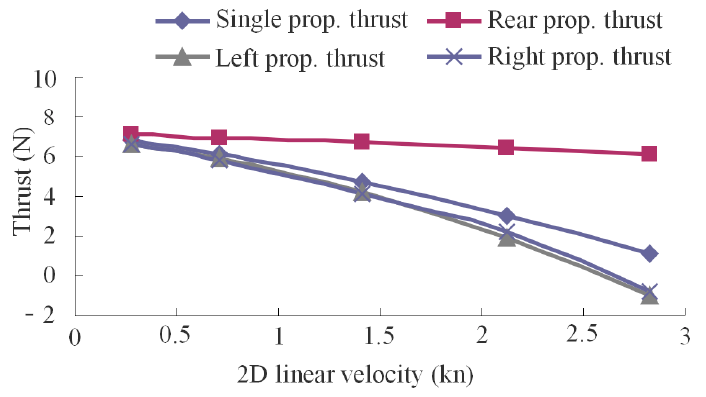
Figure 15. The two-dimensional linear motion of each propeller thrust curve.